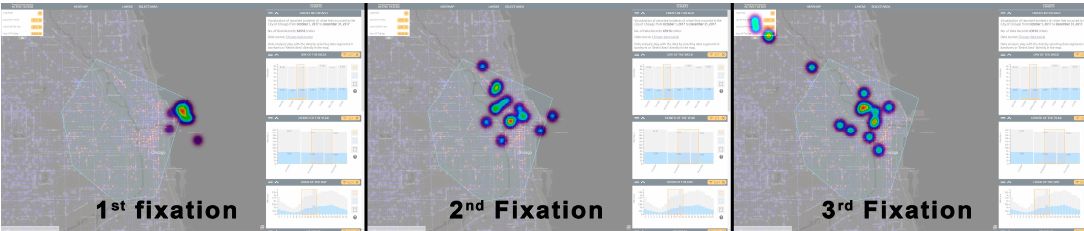
Figure 4. Attention map for stimulus 1 of Chicago map showing first, second, and third fixation.